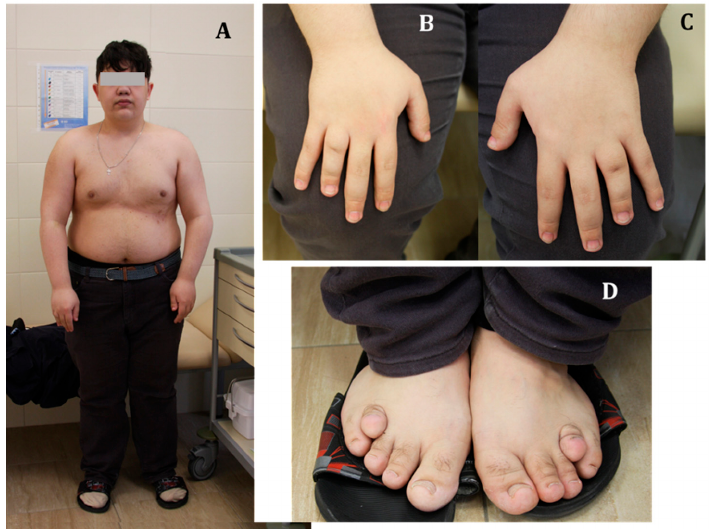
Figure 1. General examination of patient T. at admission. ( A ) General appearance of the patient. ( B , C ) The right and left hands, respectively. ( D) Patient’s feet.